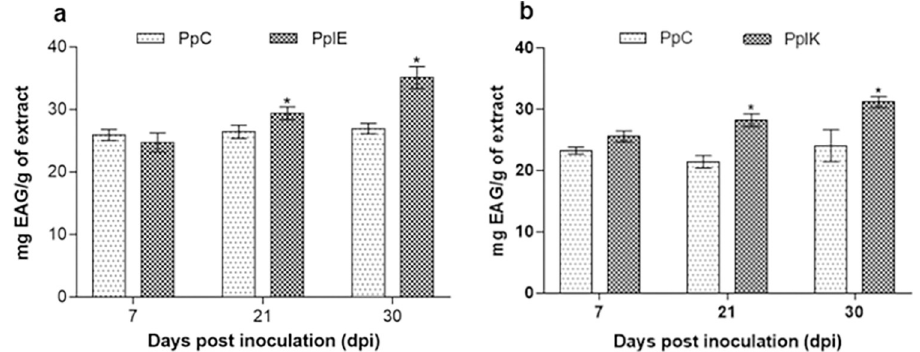
Fig 3. Total phenolic compounds of plants inoculated (n = 3) with Enterobacter asburiae (A) and Klebsiella variicola (B). � Statistically different according to Bonferroni test ( p < 0.05). dpi : Days post inoculation. PpC : P . pellucida control. PpIE : P . pellucida inoculated with Enterobacter asburiae . PpIK : P . pellucida inoculated with Klebsiella variicola .